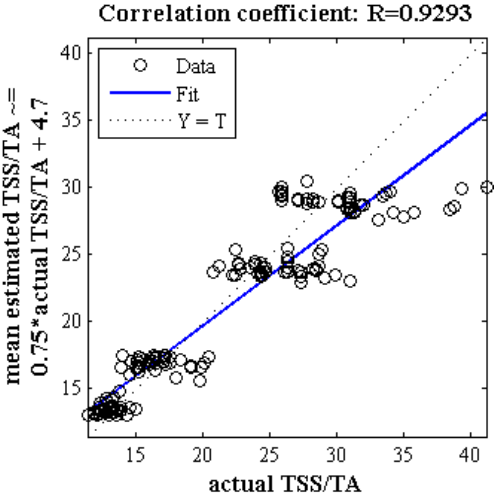
Figure 4. Correlation analysis of scatter plot between mean estimated and measured taste index of Gala cultivar using ANN-PSO algorithm based on spectral data related to key wavelengths in 300 iterations.